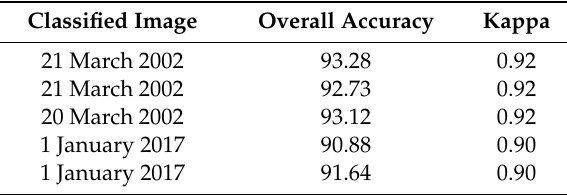
Figure 10. Land-use / land-cover change in the Ligua and Petorca valleys between 2002 and 2017 ( a and Figure 10. Land-use/land-cover change in the Ligua and Petorca valleys between 2002 and 2017 ( a b ). and b ). Table 3. General classification Table 3. General classification precisions.